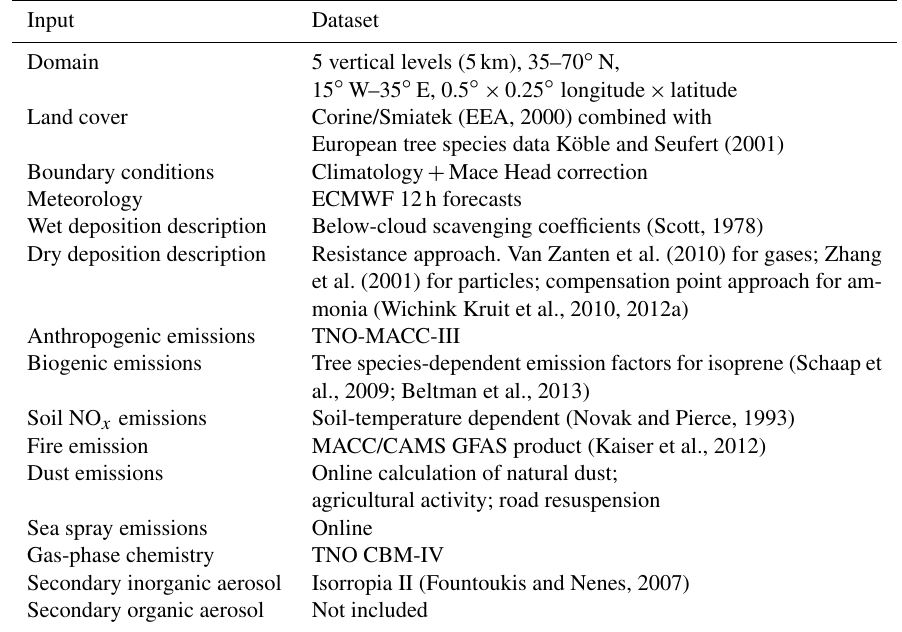
Table 1. Input datasets used in LOTOS–EUROS model run for performance